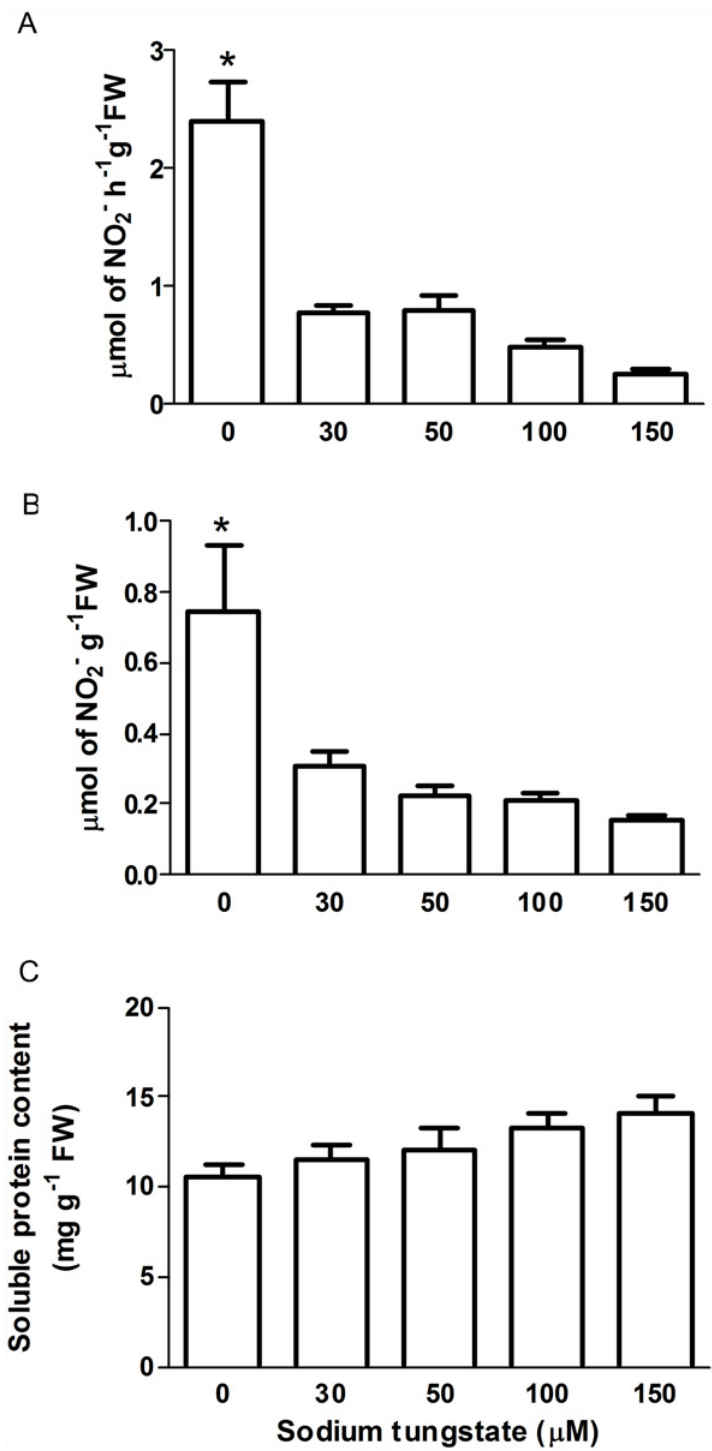
Fig 1. Analysis of the effect of sodium tungstate in P. patens protonema. A) Nitrate Reductase activity. B) Plant endogenous nitrite content. C) Plant total soluble proteins. Plants grew for seven days in simple Knop medium or media supplemented with increasing concentrations of sodium tungstate. Data are mean of three independent experiments. Data were analyzed by one-way ANOVA and Tukey´s multiple comparison test ( n = 9 in panel A, n = 3 in panels B and C). Asterisk denotes statistically significant difference ( P < 0.05). Error bars denote SE.